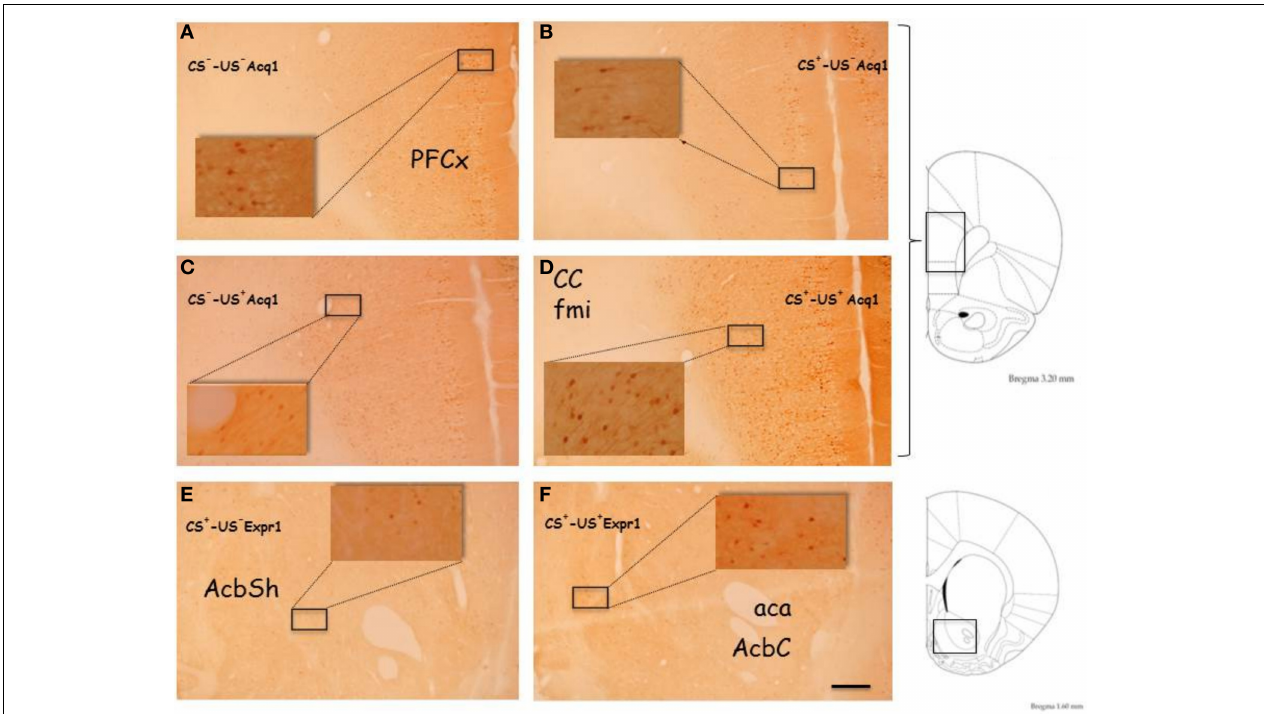
FIGURE 5 | Representative, low (5X) and high (40X, inserts) magnification images of p-ERK immunostaining from PFCx of CS − -US − (A, Acq1) and CS + -US − rats (B, Acq1), fom PFCx of CS − -US + (C, Acq1) and CS + -US + rats (D, Acq1) and from Acb of CS + -US − (E, Expr1) and CS + -US + rats (F, Expr1). The images on the right are taken from Paxinos and Watson (1998) rat brain